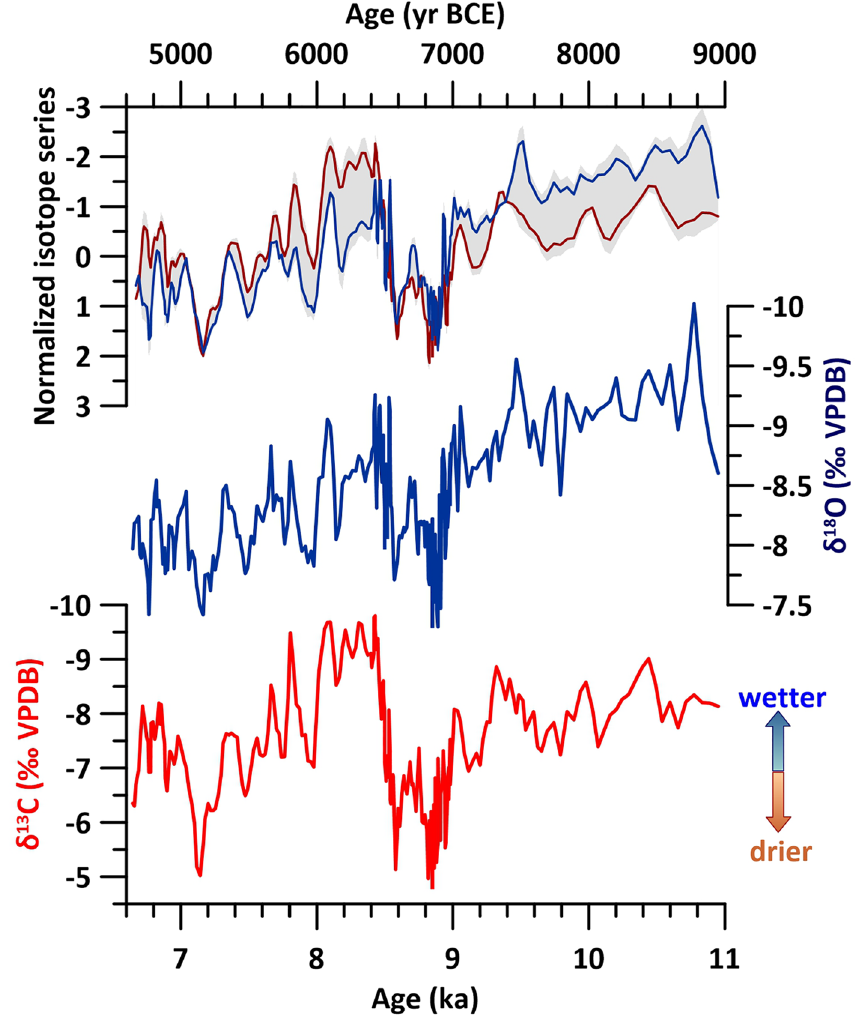
Figure 2. Stable carbon (δ 13 C, red) and oxygen (δ 18 O, blue) isotope series for flowstone LoNAP514; top: 3 points- smoothed and normalized isotope time series (SOM text), the grey band represents the standard deviation between the normalized series (see Supplementary